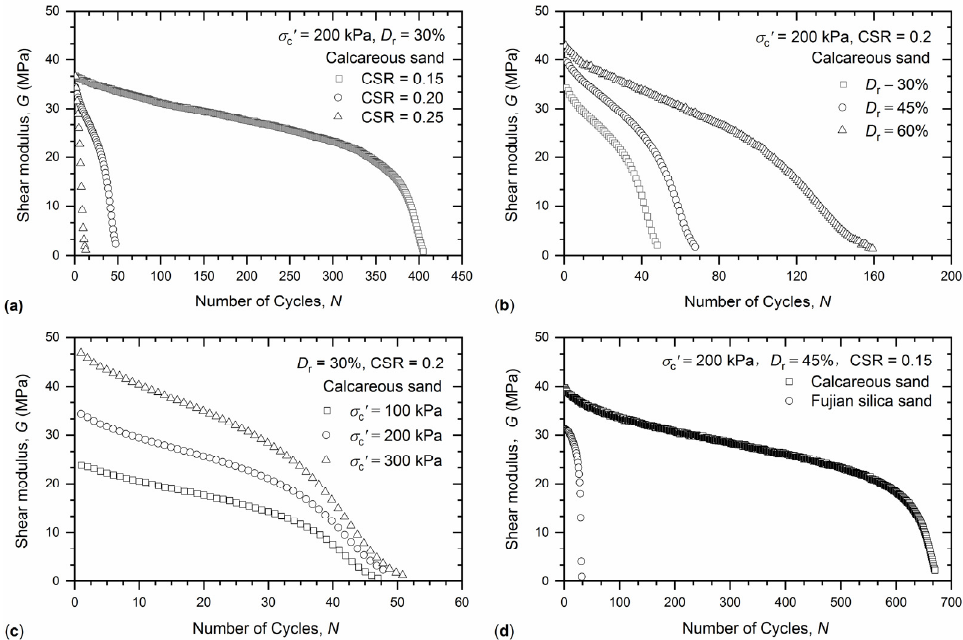
Figure 9. Comparison of shear modulus versus number of cycles: ( a ) calcareous sand with different cyclic stress ratios, ( b ) calcareous sand with different relative densities, ( c ) calcareous sand with different effective confining pressures, ( d ) calcareous sand and Fujian silica sand with the same loading conditions.